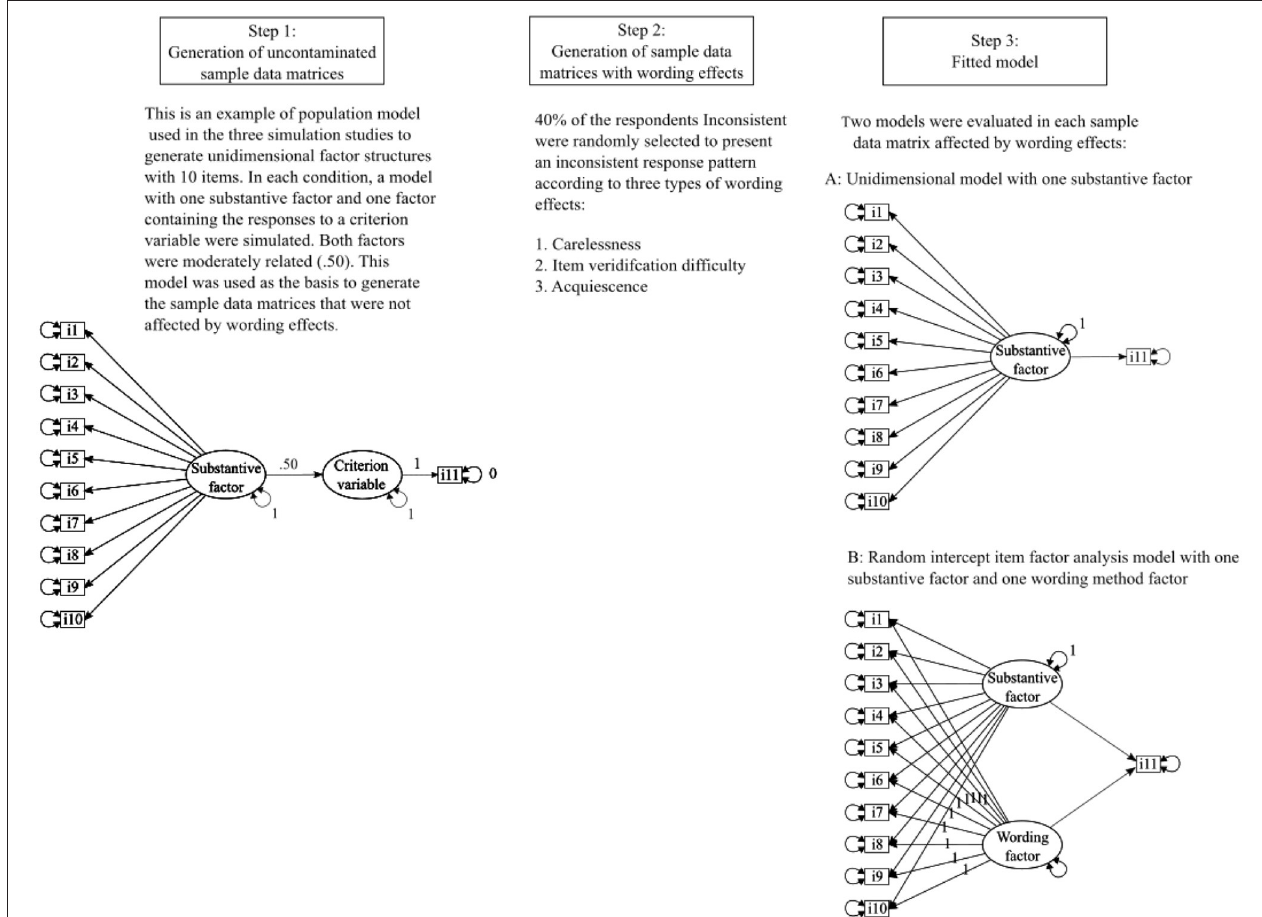
FIGURE 1 | Flowchart diagram describing the main steps of the three simulation